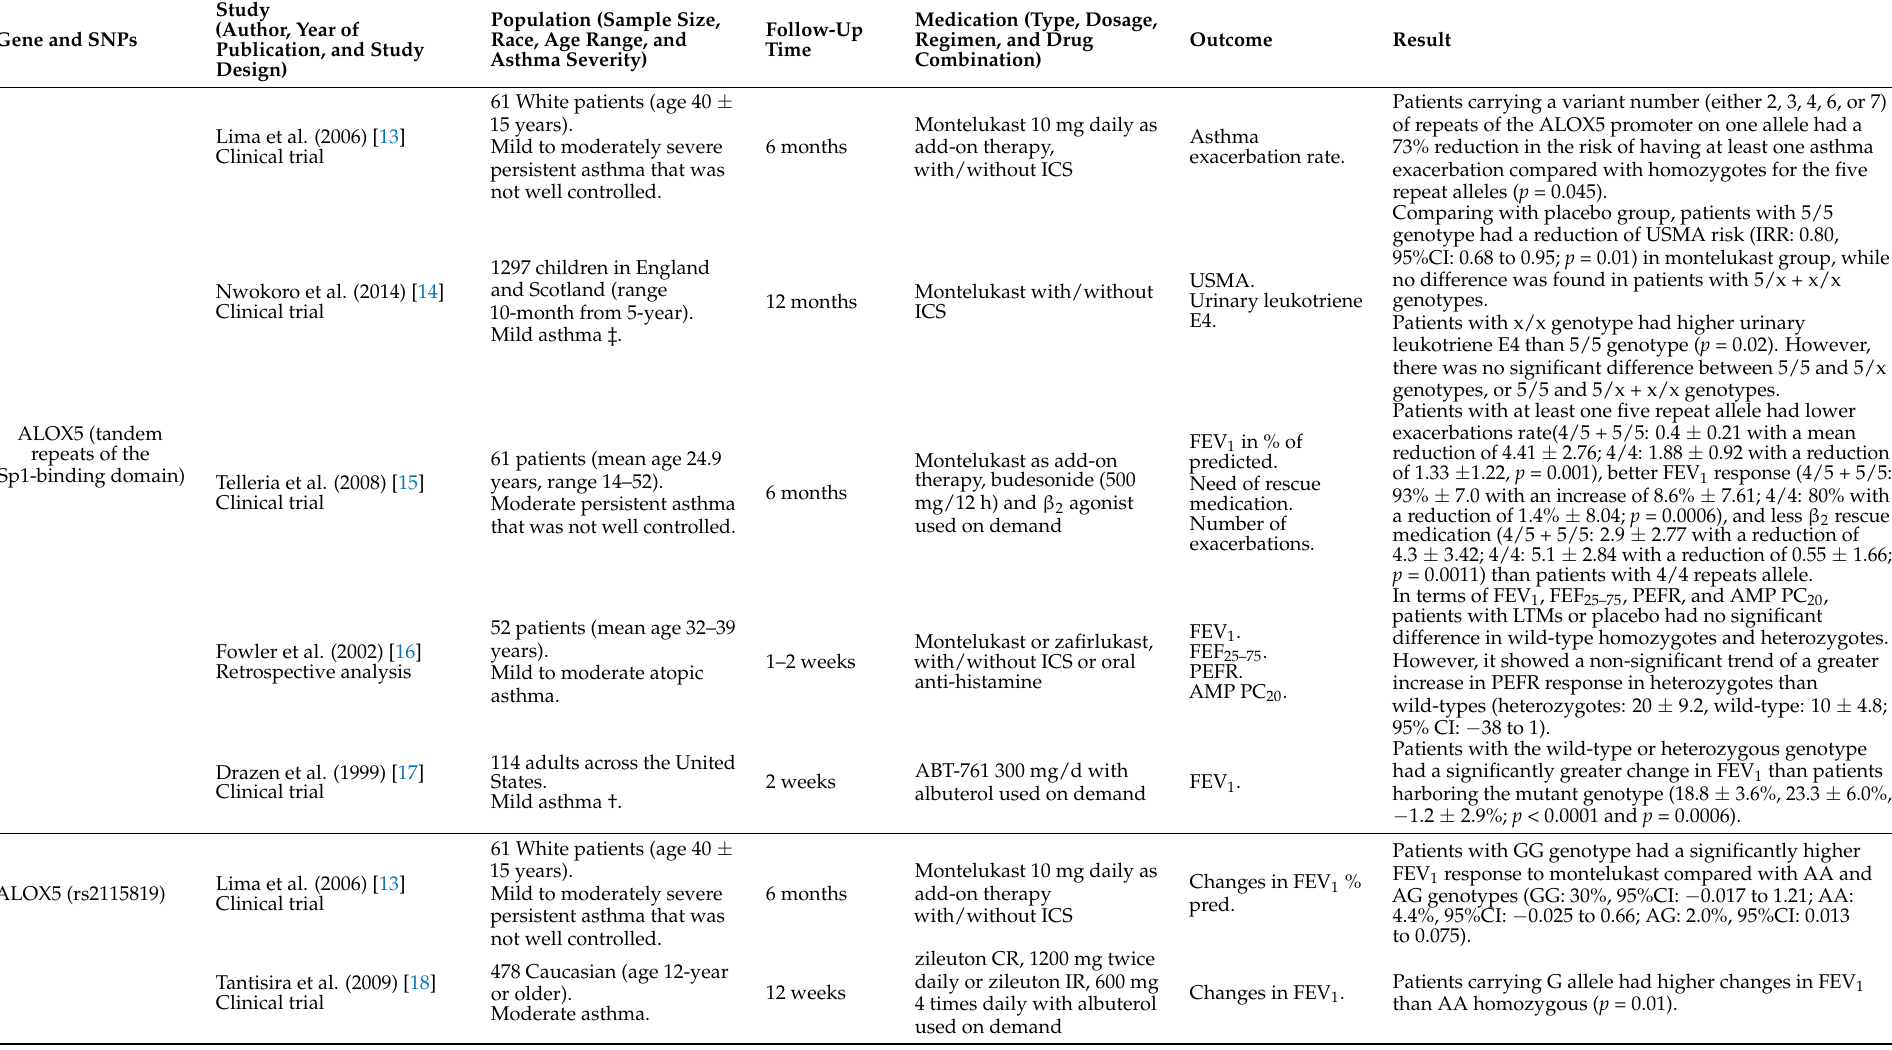
Table 2. ALOX5 gene pharmacogenomics studies of response to